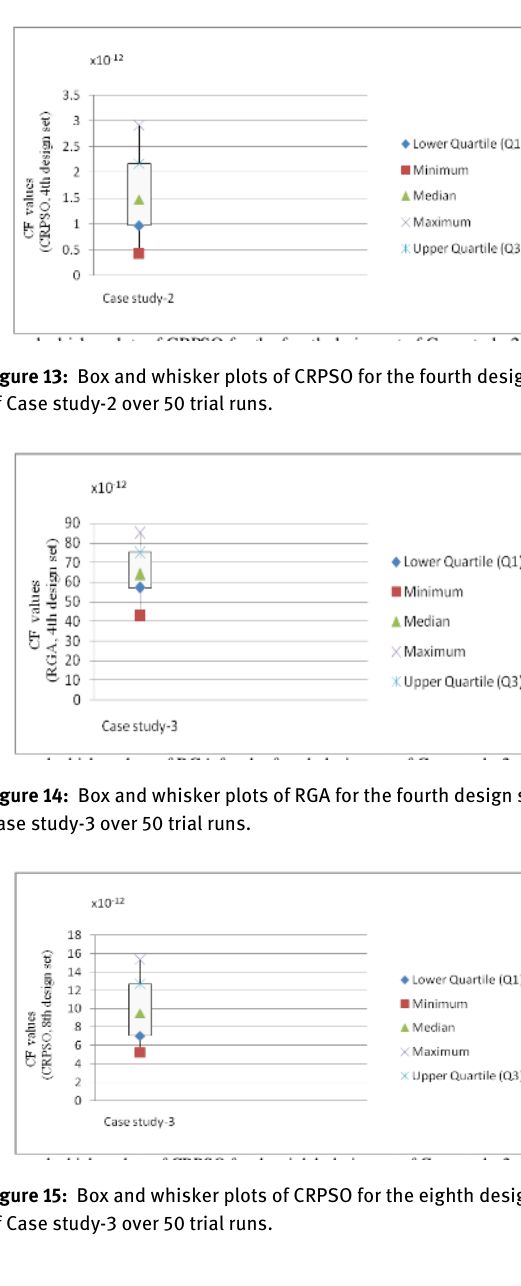
Figure 12: Box and whisker plots of RGA for the first design set of Case study-2 over 50 trial runs.